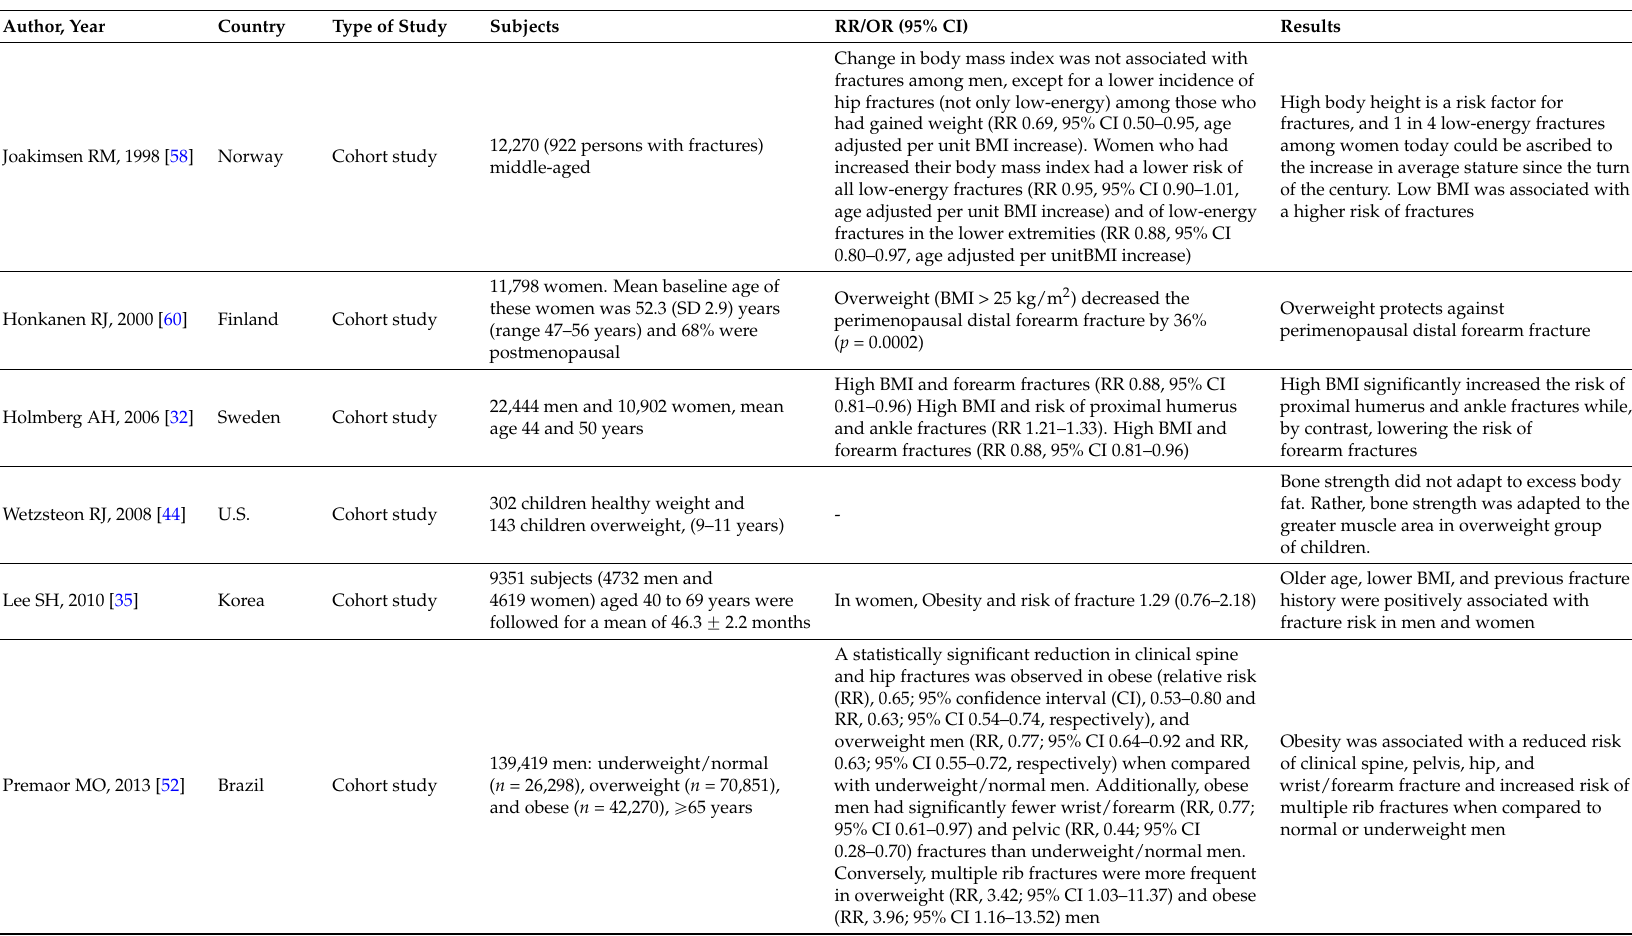
Table 2. Cohort studies focused on the relation between obesity and bone health in